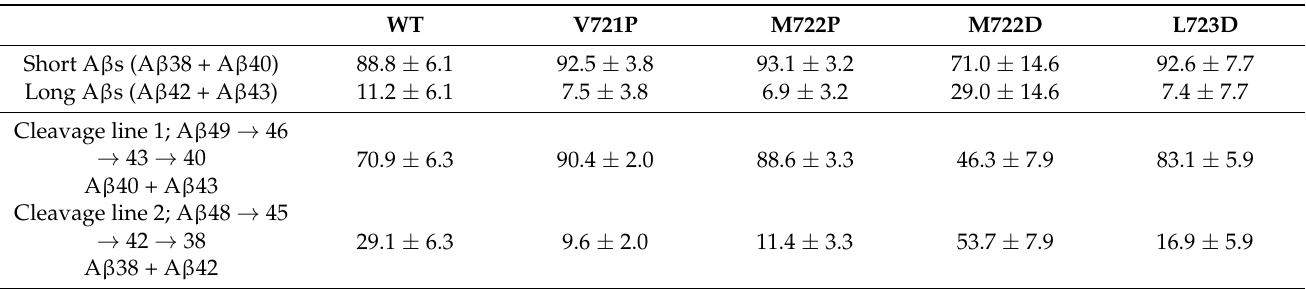
Table 4. Summary of the proportions of A β species produced by APP WT and secondary mu- tants in CHO cells. Percentages were expressed as the average of four independent assays ± 95% confidence interval. WT V721P M722P M722D L723D 88.8 ±